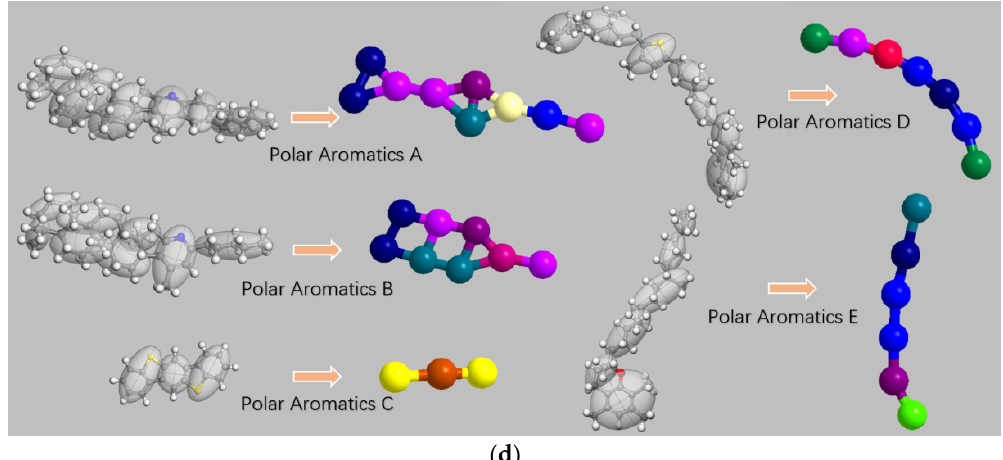
Figure 2. The mapping scheme of the bitumen molecule model. ( a ) Mapping scheme of asphaltenes. ( b ) Mapping scheme of saturates. ( c ) Mapping scheme of aromatics. ( d ) Mapping scheme of polar aromatics.